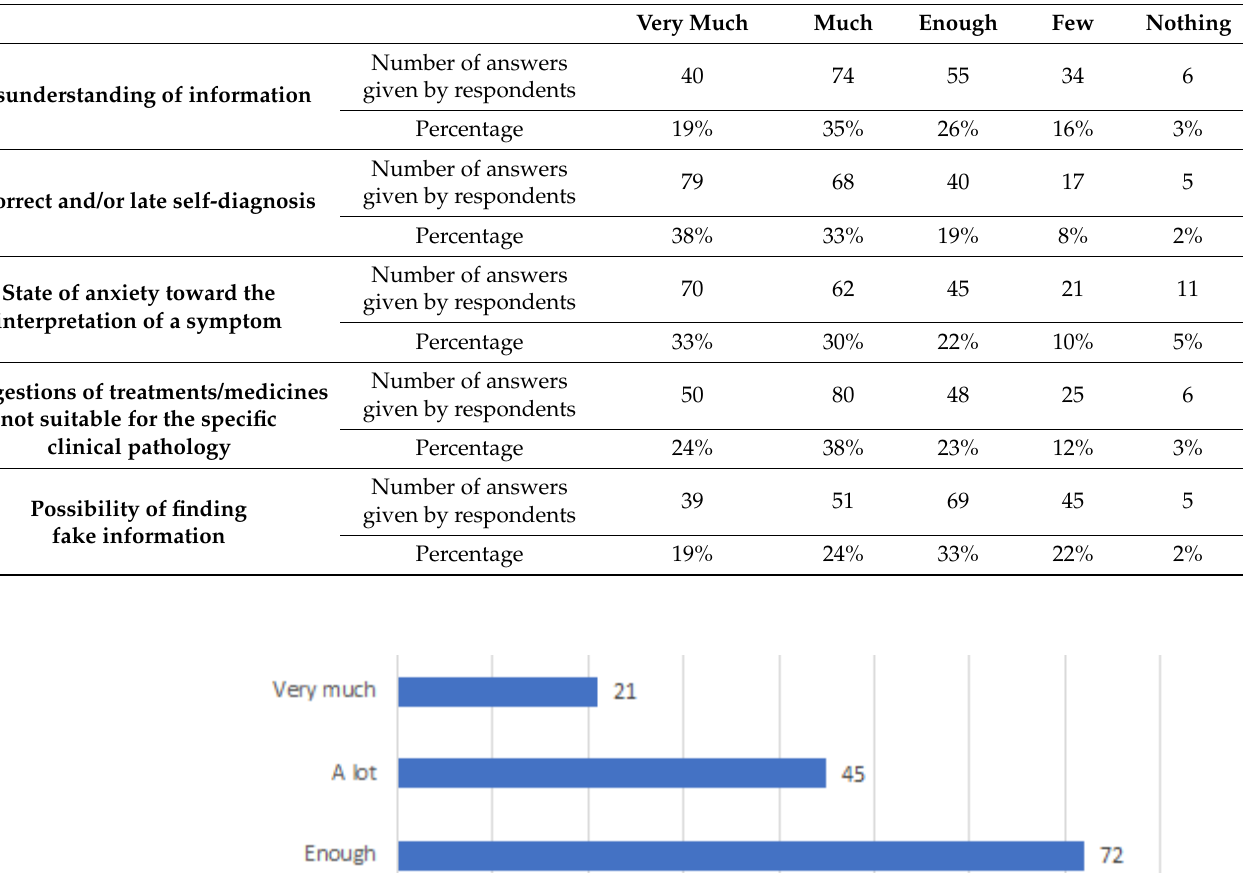
Table 7. Risks of searching for online health information.